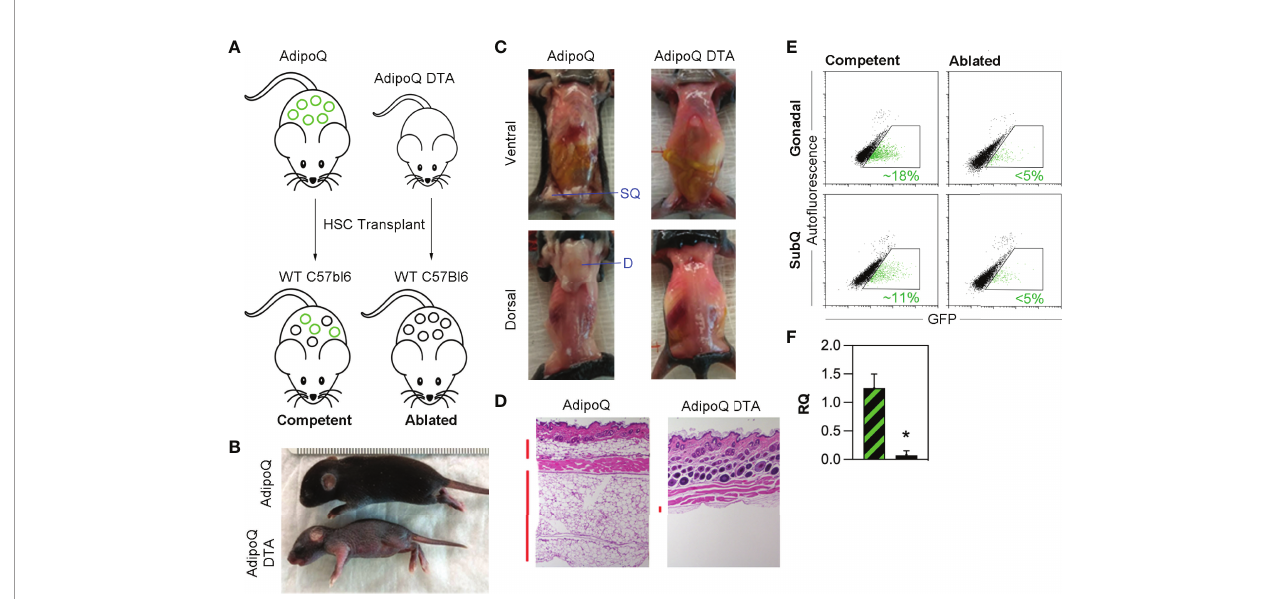
FIGURE 1 | Triple transgenic model for speci fi c depletion of HSCDAs. (A) AdipoQ donor mice were generated by crossing mice in which the adiponectin gene promoter (AdipoQ) drove cre recombinase expression with mice bearing a fl oxed tdTomato and EGFP reporter gene at the ROSA locus (ROSA mTmG/+ ). AdipoQ DTA donor mice also contained the AdipoQ cre and fl oxed EGFP genes, plus a fl oxed diphtheria toxin subunit a (DTA) transgene (ROSA mTmG/DTA ). These mice were used as donors for HSC transplant in female, wild-type C57Bl/6J recipient mice to generate HSCDA Competent and Ablated mice for experiments. Conventional adipocytes are shown as black circles and HSCDAs as green circles (B) Donor AdipoQ DTA pups were substantially smaller than AdipoQ donor mice of the same age. (C) AdipoQ DTA donor mice lacked dorsal and inguinal subQ adipose tissue, which were present in the AdipoQ mice. The position of each fat depot is indicated by blue label and line. (D) Bright fi eld microscope images (10x) of hematoxylin and eosin stained skin cross sections show normal levels of subdermal adipocytes in AdipoQ mice, but almost none in AdipoQ DTA mice. Vertical red bars to the left of each image highlight the adipocyte layers. (E) Flow cytometry of free- fl oating adipocytes from the gonadal and subcutaneous adipose tissue from each HSC recipient cohort revealed the presence of GFP POS HSCDAs in the Competent mice (green events in the gated region, average GFP POS HSCDAs indicated in green font), which were signi fi cantly reduced in the Ablated cohort. (F) Quantitative RT-PCR of GFP gene expression in gonadal adipose tissue samples from Competent (black/green crosshatch bar) and Ablated (solid black bar) mice. GFP signals were corrected for b 2-microglobulin RNA levels. (n=3 per group, * indicates p ≤